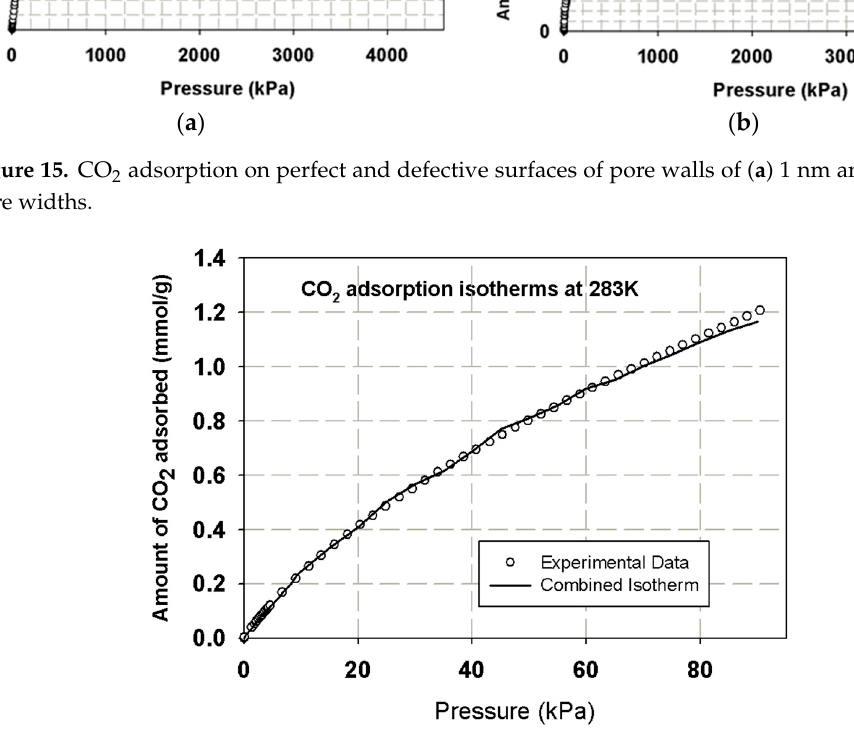
Figure 17. Calculated PSD obtained from CO 2 adsorption isotherms using GCMC simulation. 5. Conclusions In this study, simple porous silica glass models for homogeneous and heterogeneous surfaces were proposed and CO 2 is used as a probe molecule for the adsorption study. The adsorption behavior of CO 2 on porous silica model depends on the pore width, surface heterogeneity and adsorption temperature. The defective surface and surface containing silanol functional groups were used to represent the surface heterogeneity effect. The amount of CO 2 adsorption decreased with the increase in pore width. The adsorption decreased with an increase in the adsorption temperature, thus indicating the physical adsorption of CO 2 in porous silica glass. CO 2 adsorption on a defective surface was higher than that on a homogeneous perfect surface, with the rapid rising of the amount adsorbed being noticed at relatively low pressures, due principally to the initial forming of two contact adsorbed layers along the pore wall . The adsorption of CO 2 increased with an increase of functional group contents due to the stronger interaction between the fluid and the silanol group. The placement scheme of the functional group also affects the adsorption isotherms; the adsorption for the fixed topology model was greater than that for the random topology model at a low - pressure range but became less than that of the random topology at higher pressures, possibly caused by the diffusion effect ( mas transfer resistance ) of CO 2 to the inner pore . The simulated isotherms for different single pore widths together with the experimental isotherm data can be used to compute